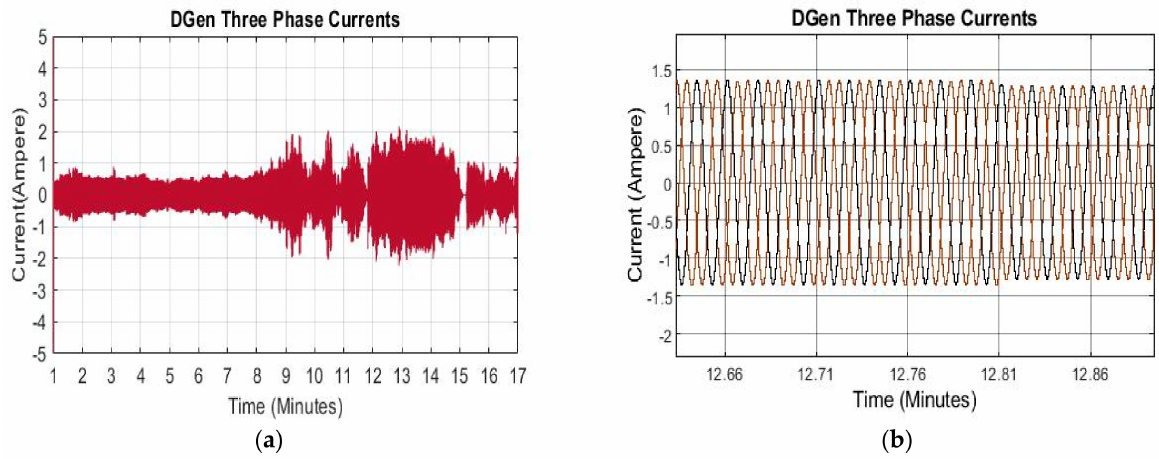
Figure 17. ( a ) Dgen three phase currents; ( b ) Zoom in view of